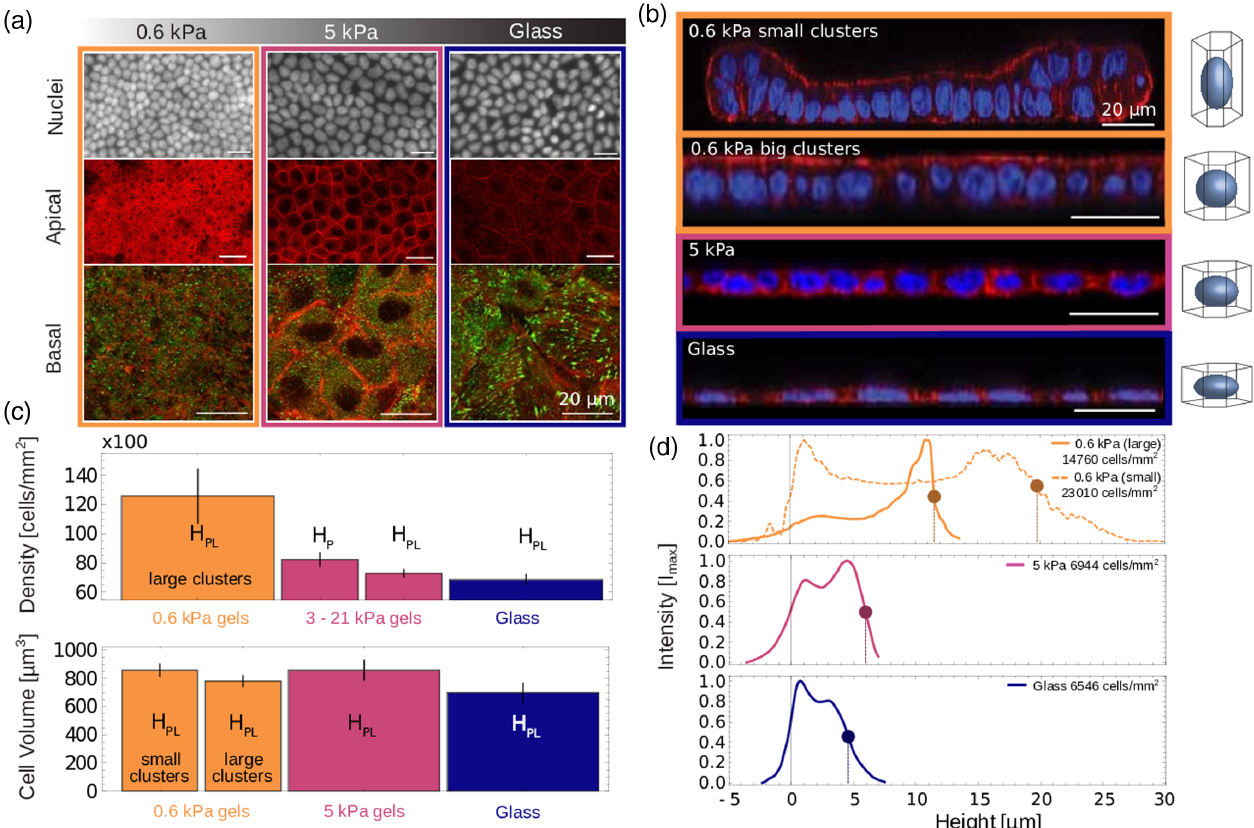
FIG. 1. Characteristics of the homeostatic state of the tissue as a function of the substrate stiffness. Tissues are grown on soft gels (orange colored frames and lines), hard gels (pink), and on glass (blue). (a) Characteristic confocal images in the plane of the monolayers fixed early in the fourth day after seeding. The top panel presents Hoechst stained cell nuclei. In the middle panel, apical phalloidin stained actin is imaged. The bottom panel shows paxillin stained using secondary antibodies in green and actin in red to visualize focal adhesions. (b) Reconstructed slice through the monolayers showing columnar MDCK-II tissue on soft gels, cuboidal tissue on hard gels, and squamous tissue on glass substrates. Actin is shown in red and nuclei in blue. Small colonies on soft gels are characterized by a monolayer area smaller than 2 . 8 × 10 − 2 mm 2 , and finite-size effects still play a role. Larger colonies are imaged away from the edge. (c) Bar charts of the average cell density (top) and volume (bottom). Error bars indicate standard deviations from measurements in different colonies grown under identical conditions. This deviation is, however, similar to standard deviations in density within a single colony (see Appendix B for details). Unlike cell volumes in different tissues, cell density shows statistically significant differences even between hard gels and glass. However, the error in the measurement of the volume, obtained from the propagation of uncertainties in measuring density and height, is of the order of 10%. Here, density was calculated from approximately 500 × 10 3 cells at 0.6 kPa, from 208 × 10 3 cells grown in tissues on substrates with stiffness between 3 and 21 kPa, and from 27 × 10 3 cells on glass (see Appendix B 2). The height was calculated for 100 (glass) to 350 cells (soft gels) depending on the density considered. The notations H for the homeostatic state with inhibition of proliferation and locomotion and for the homeostatic state with inhibition of proliferation, respectively. (d) Average intensity of the stained actin as a function of the distance from the substrate. The height of the monolayer is determined as the difference in heights between the two inflection points in the intensity curves. For simplicity, all inflection points at the basal surface are co-aligned. The circles indicate the apical surface. The density in the presented segment where the volume is measured is indicated in each